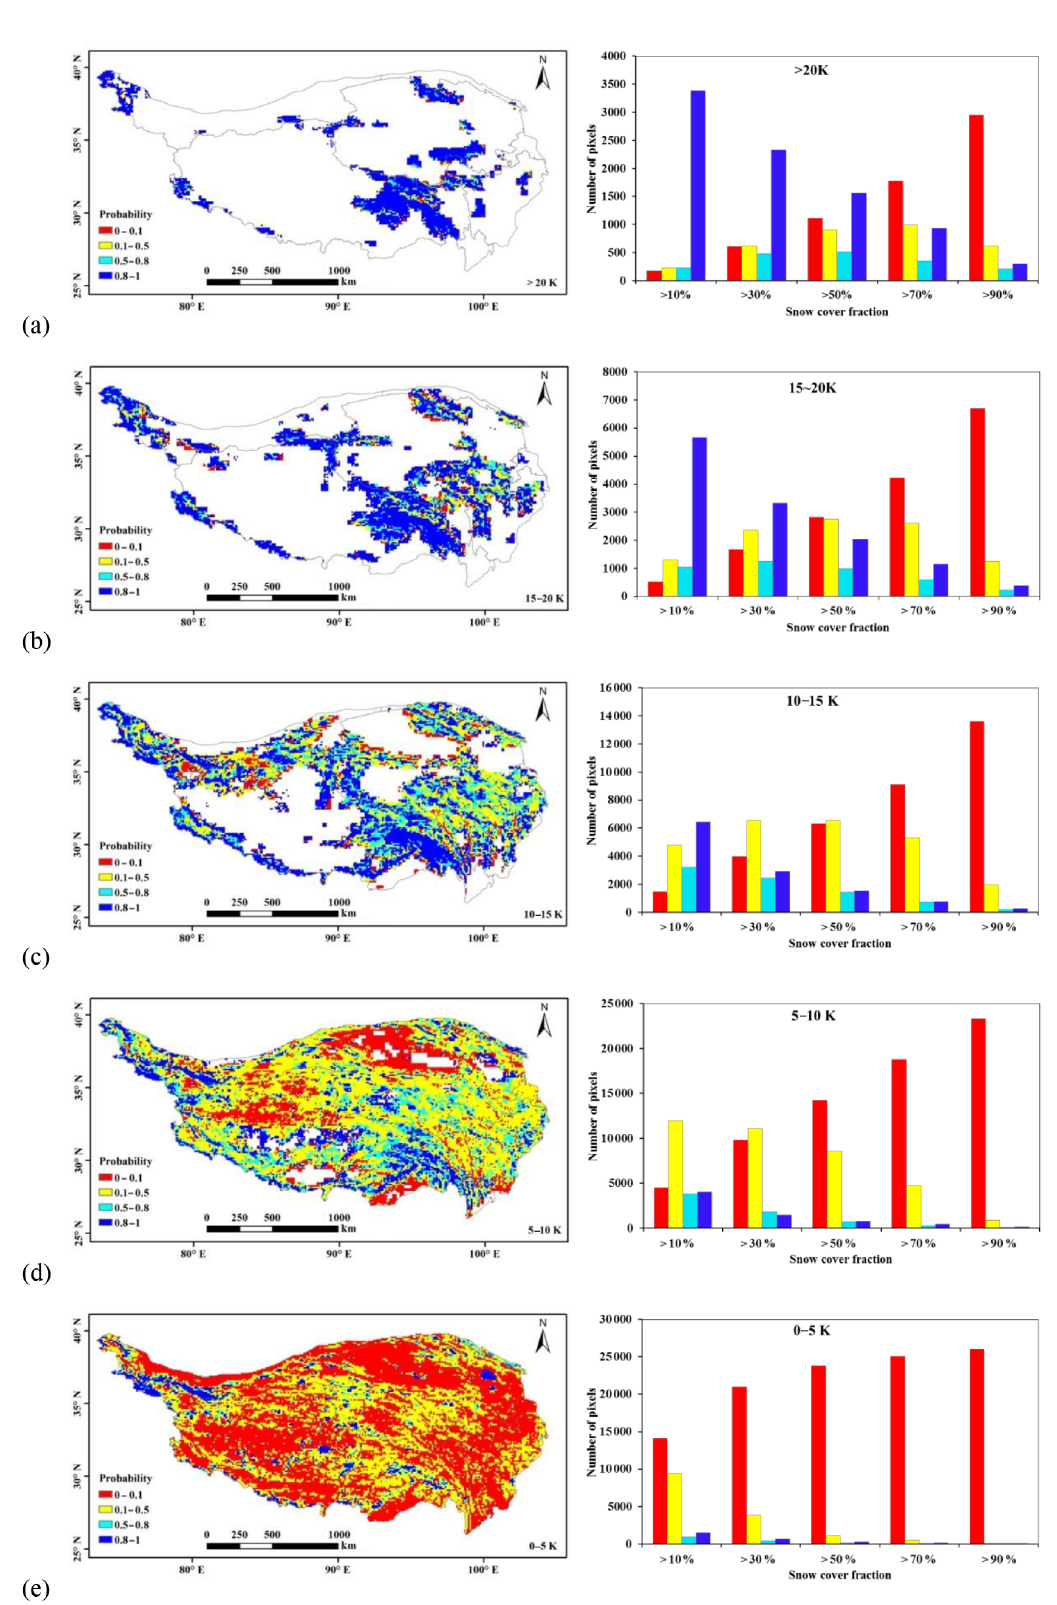
Figure 3. Spatial distribution of frequency of SCF greater than 10% across the QTP and histograms of frequency for each SCF group. (a) TBD>20K. (b) 15K<TBD ≤ 20K. (c) 10K<TBD ≤ 15K. (d) 5K<TBD<10K. (e) TBD ≤